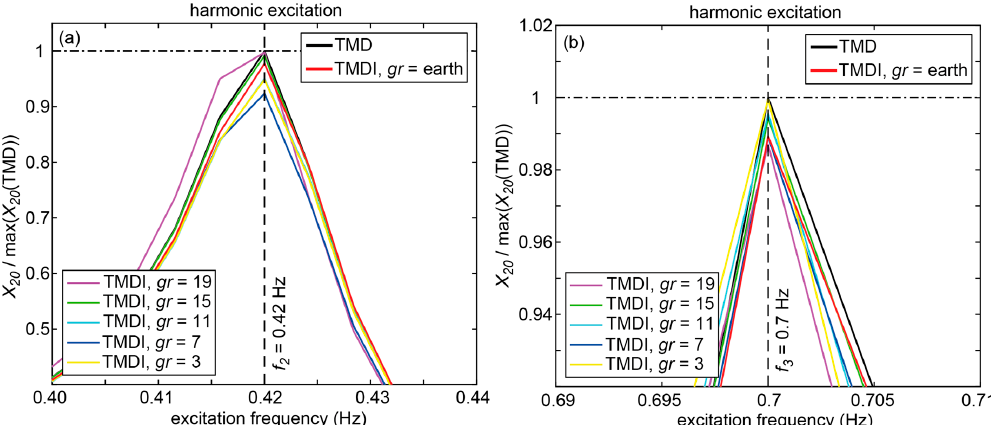
Figure 6. Results for the frequency range of mode 1: ( a ) structural displacement of level 20 normalized by the maximum value due to the TMD; ( b ) structural acceleration of level 20 normalized by the maximum value due to the TMD; ( c ) relative pendulum motion normalized by the maximum value due to the TMD.